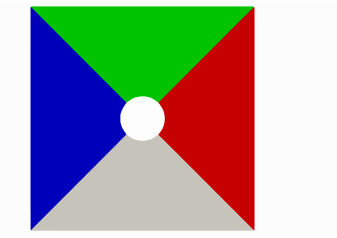
Figure 4. Case 1: the multipatch